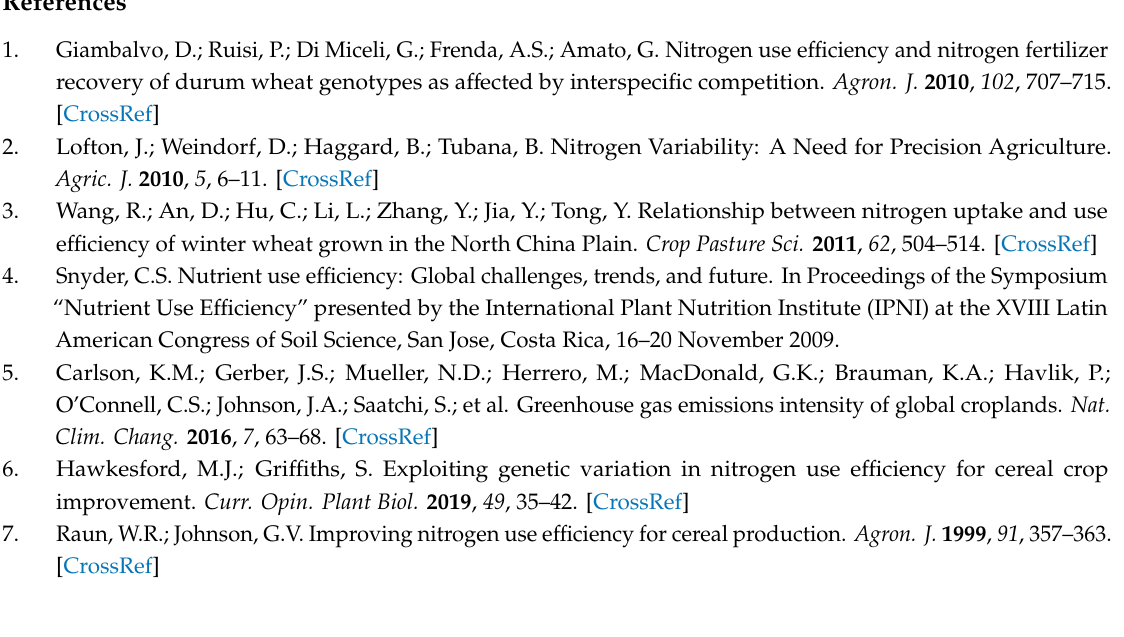
Table S1: Four common definitions and methods of calculating Nitrogen Use E ffi ciency (NUE) [19,20], Table S2: One-way ANOVA for PFP and PNB for site year 2010 and 2011 across two irrigation conditions (dryland and